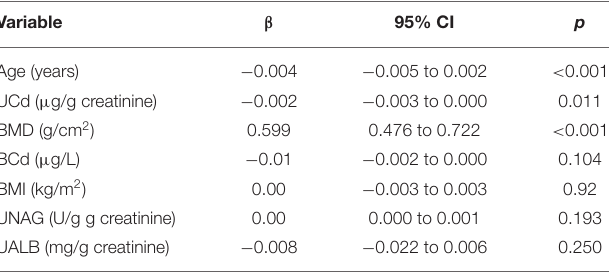
TABLE 2 | Associations between baseline variables and follow-up BMD in multiple linear regression